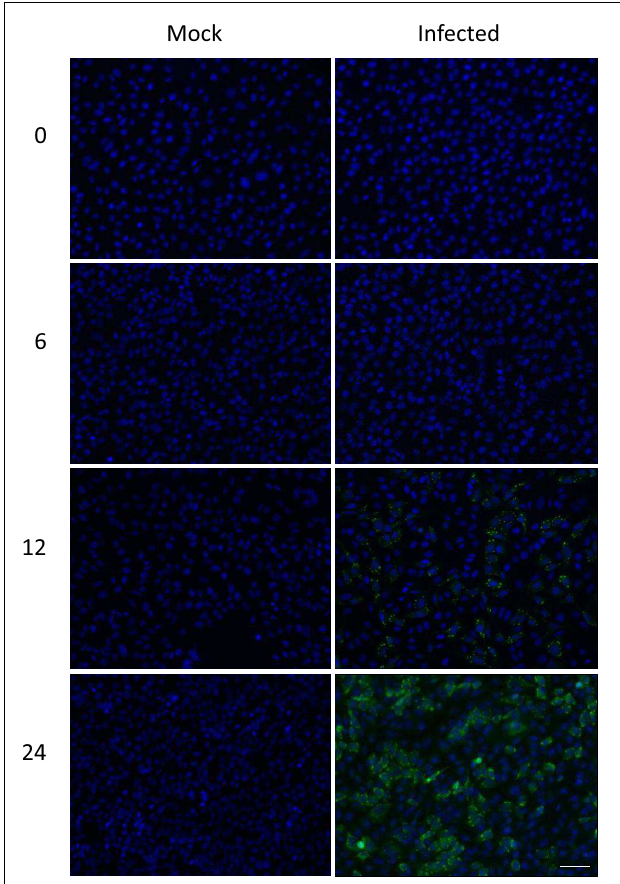
FIGURE 2 | Confirmation of HeLa cell infectivity. HeLa cells were mock-infected (left), or infected with MRV strainT3D at an MOI of 7 (right). Cells were harvested at indicated times post-infection (left) and processed for immunofluorescence microscopy, using in-house rabbit anti-reovirus and Alexa-488-conjugated secondary anti-rabbit antibody (green) and DAPI (blue). Scale bar is 50 µ